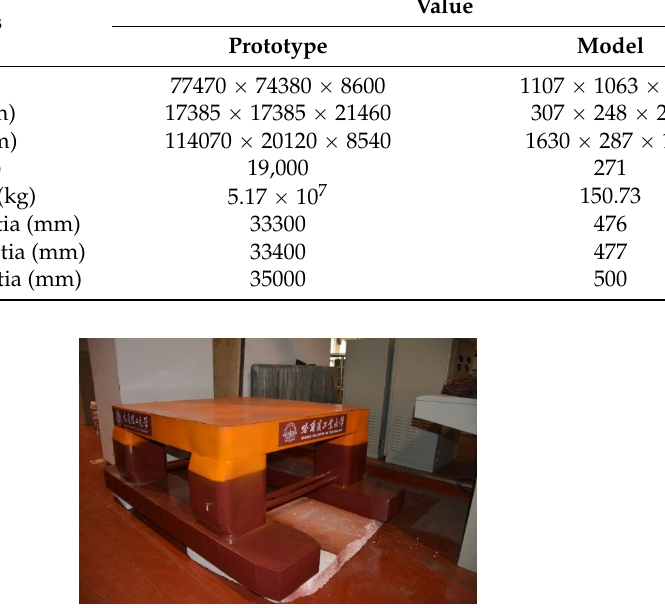
Table 1. The physical parameters of the prototype and scale model of the semi-submersible.